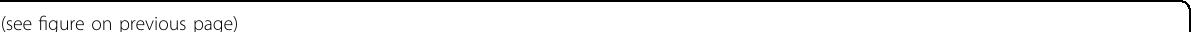
Fig. 4 Circ_0026628 competed with SP1 for the binding of miR-346. A RIP assay revealed the enrichment of circ_0026628 and SP1 pulled down by anti-IgG and anti-Ago2. Student ’ s t -test. B Venn diagram revealed the miRNAs binding to both circ_0026628 and SP1 based on the starBase database. C RNA pull-down assay tested the enrichment of 8 candidate miRNAs pulled down by Bio-NC and Bio-circ_0026628-WT. Student ’ s t -test. D qRT-PCR analyzed the expression pro fi le of miR-346 and miR-326 in CRC cells and the control cells. One-way ANOVA. E qRT-PCR veri fi ed the overexpression ef fi ciency of miR-346; qRT-PCR and western blot disclosed the in fl uence of miR-346 mimics on SP1 expression. Student ’ s t -test. F RIP assay estimated the enrichment of circ_0026628, miR-346, and SP1 in anti-Ago2 groups relative to anti-IgG groups. Student ’ s t -test. G Binding sites between circ_0026628/SP1 and miR-346 predicted by starBase, and the mutant circ_0026628/SP1 constructed based on indicated sites. H Luciferase reporter assay determined the luciferase activity of wild-type and mutant circ_0026628/SP1 in CRC cells with miR-346 mimics. Student ’ s t -test. * P < 0.05, ** P < 0.01. “ n.s. ” indicates no signi fi